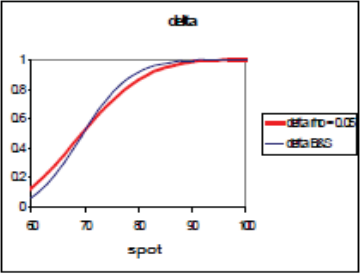
Fig. 11. The B&S gamma hedging strategy Fig. 12. The B&S delta hedging